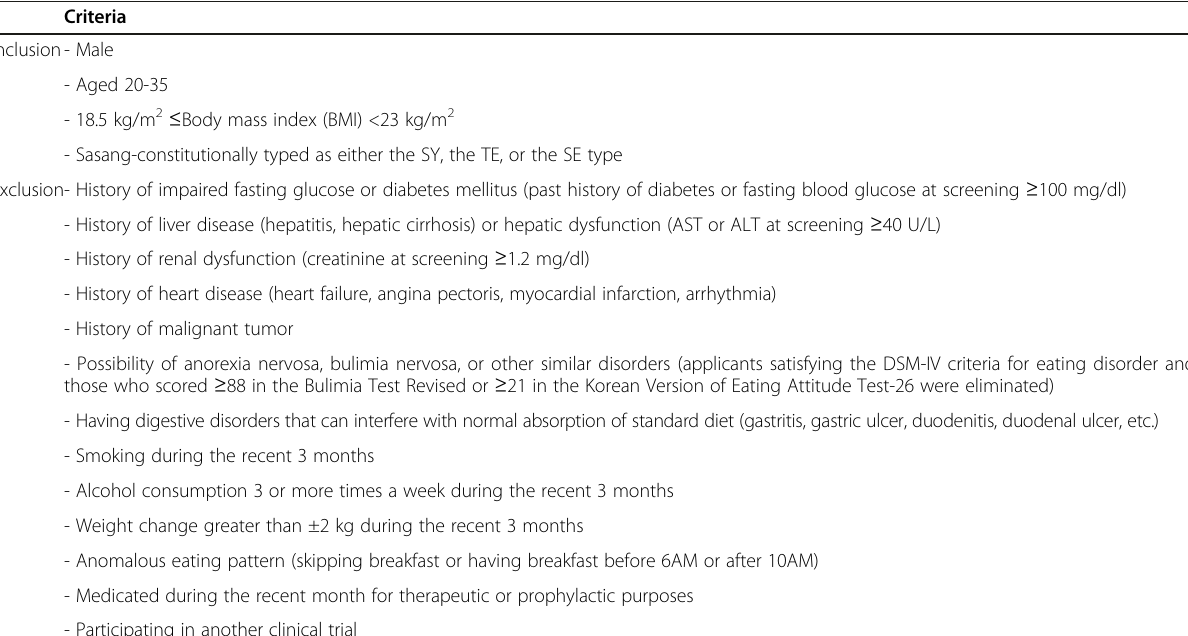
Table 2 Inclusion and exclusion criteria